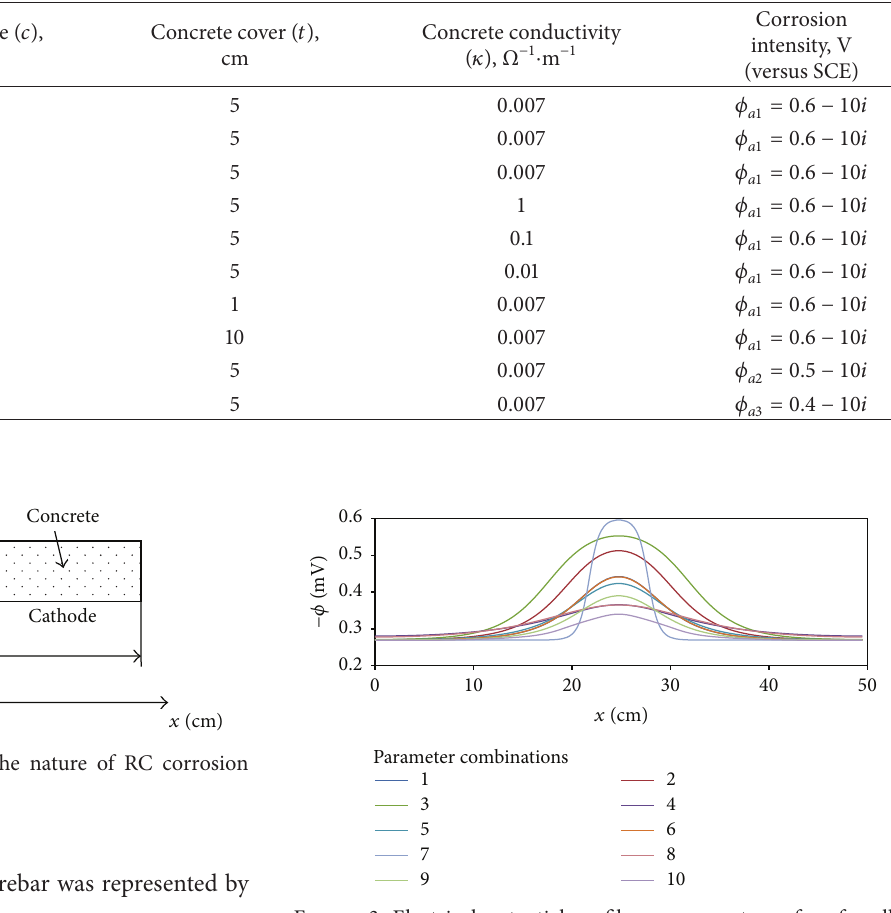
Figure 3: Electrical potential profiles on concrete surface for all combinations of